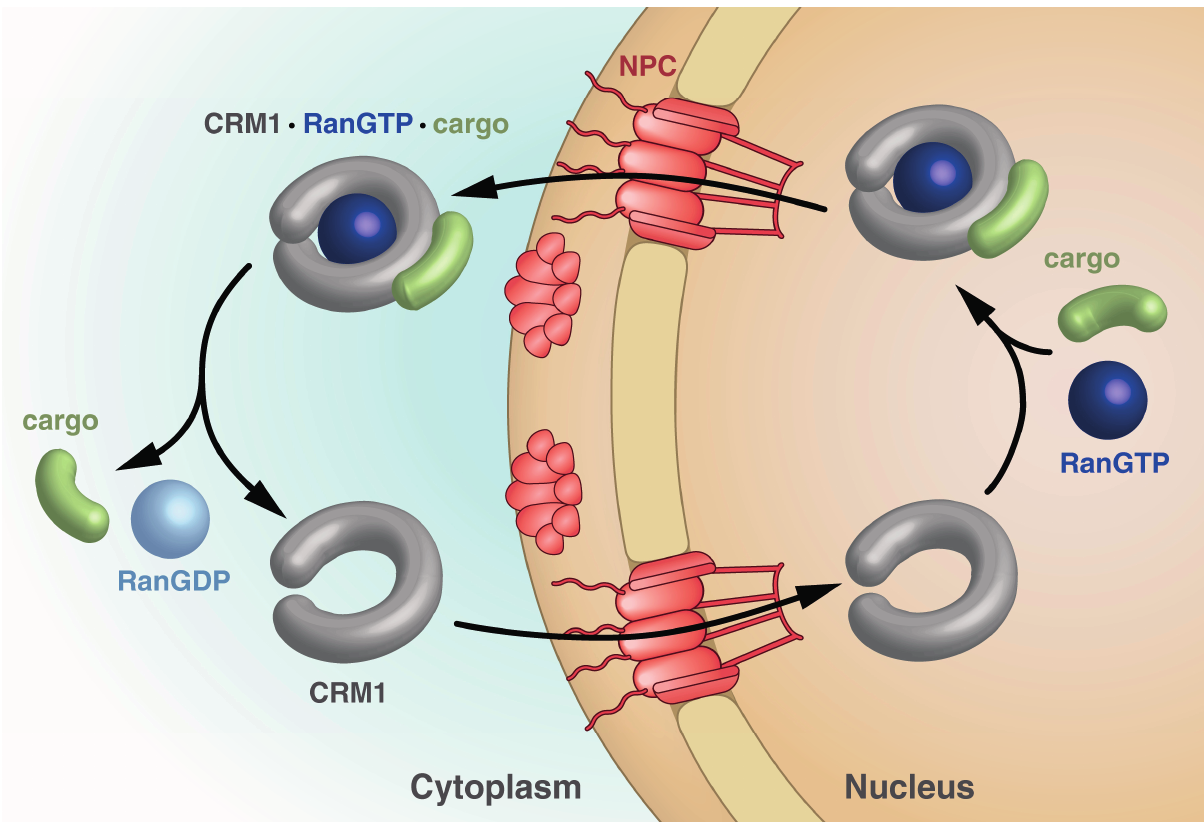
Figure 2. Schematic drawing of the steps within the CRM1 transport cycle. The steps depicted highlight the different states of CRM1 with respect to the overall shape as well as points of cargo and RanGTP binding and release. See text for